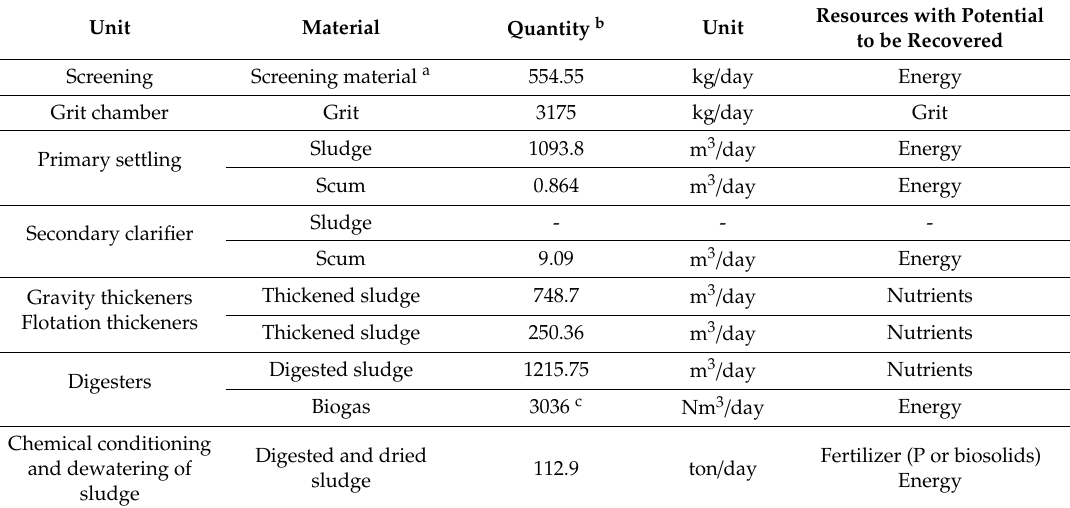
Table 3. Quantitative data of by-products of the wastewater treatment plant (WWTP) and potential resources.